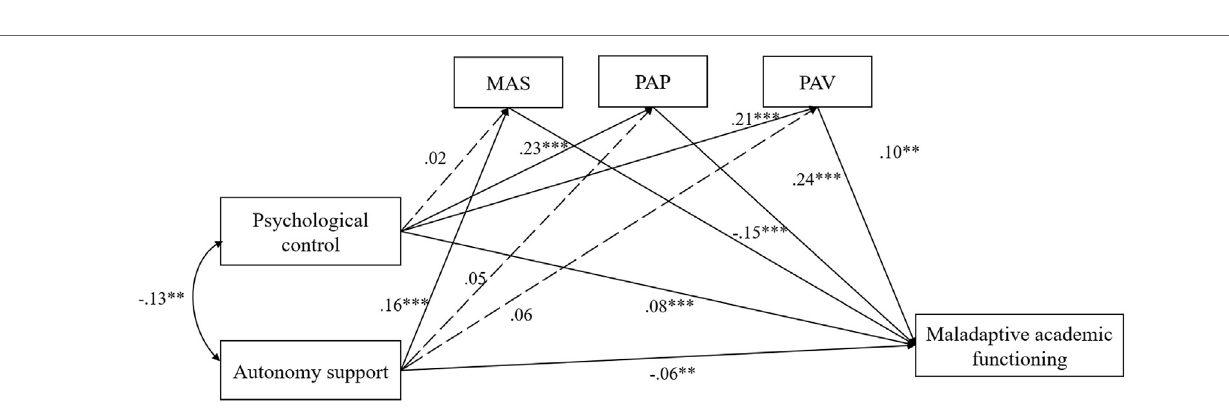
FigUre 2 | Students’ achievement goal orientations as mediators of the relation between parenting and maladaptive academic functioning. Abbreviations: MAS, mastery goal orientation; PAP, performance-approach goal orientation; PAV, performance-avoidance goal orientation. Students’ gender was controlled as a covariate. Values represent standardized regression coefficients. ** p < 0.01, *** p < 0.001.